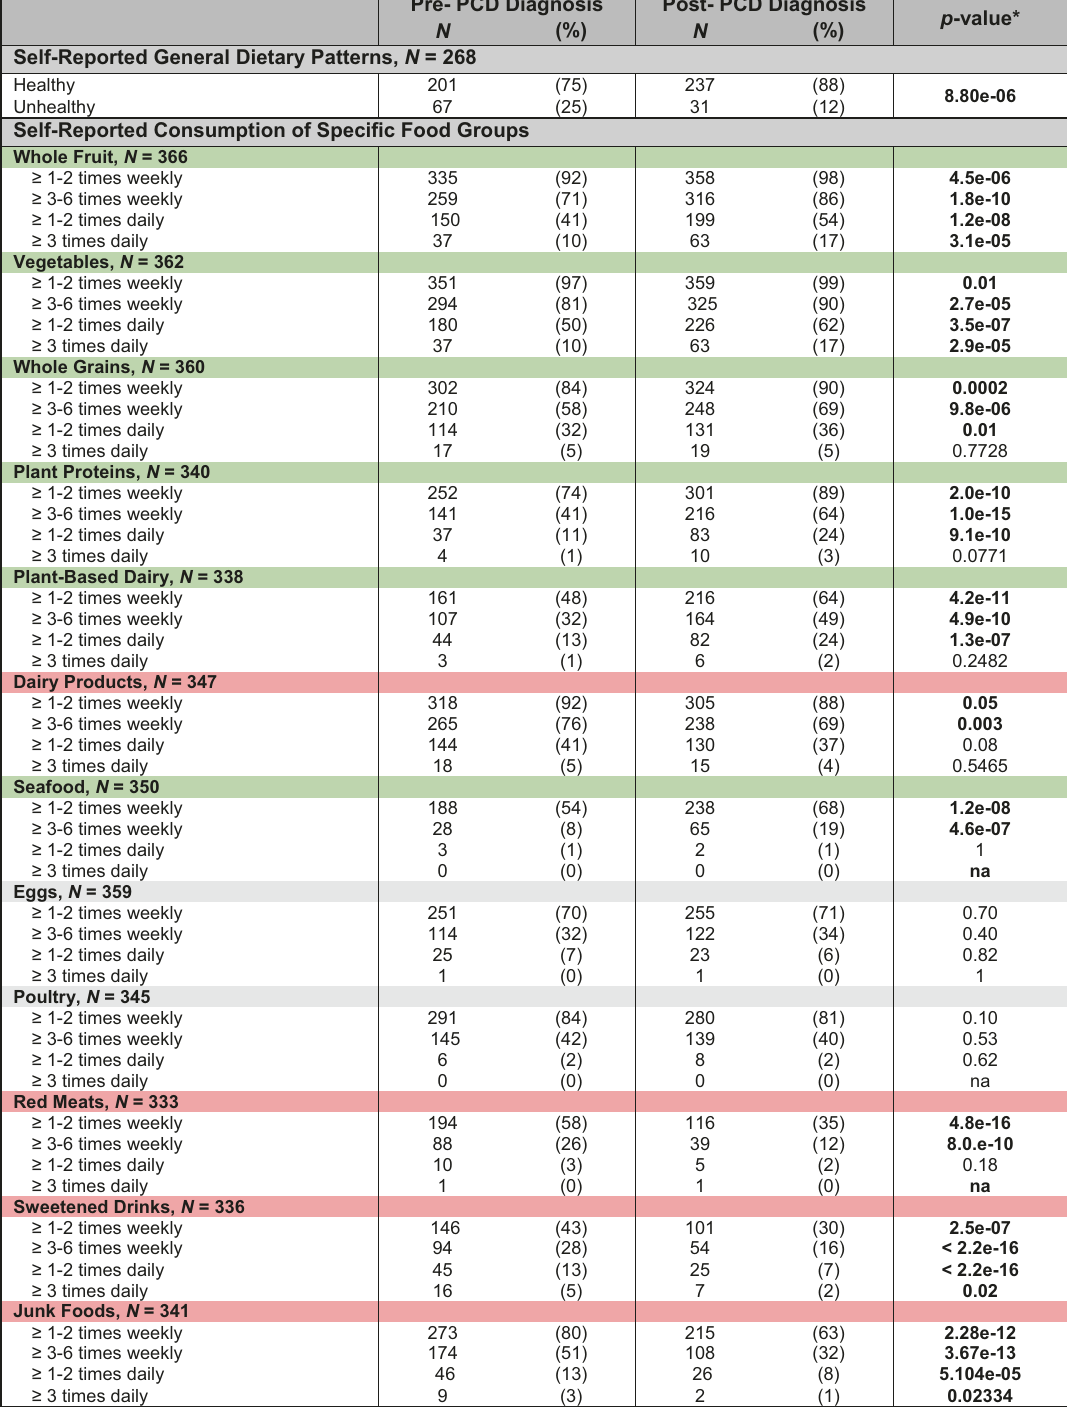
Table 2. Self-reported dietary patterns in patients pre-PCD diagnosis versus post-PCD diagnosis. Pre- PCD Diagnosis Post- PCD